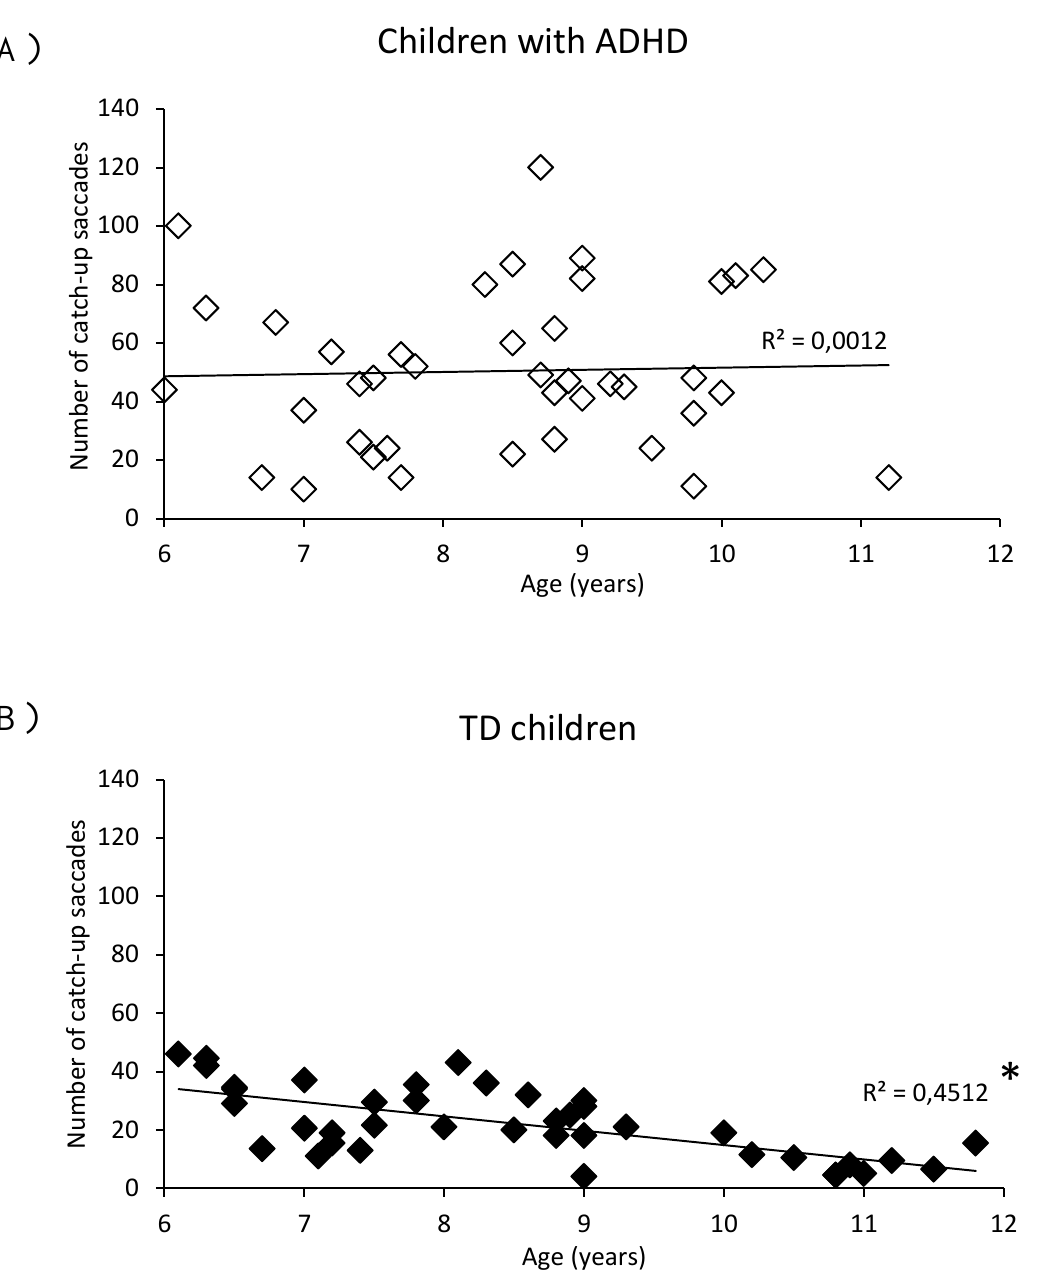
Figure 1. Number of catch-up saccades made by children with attention deficit hyperactive disorder (ADHD) ( A ) and with typical development (TD) ( B ) in correlation with their chronological age at inclusion. Line represents the corresponding regression by age. *: p <